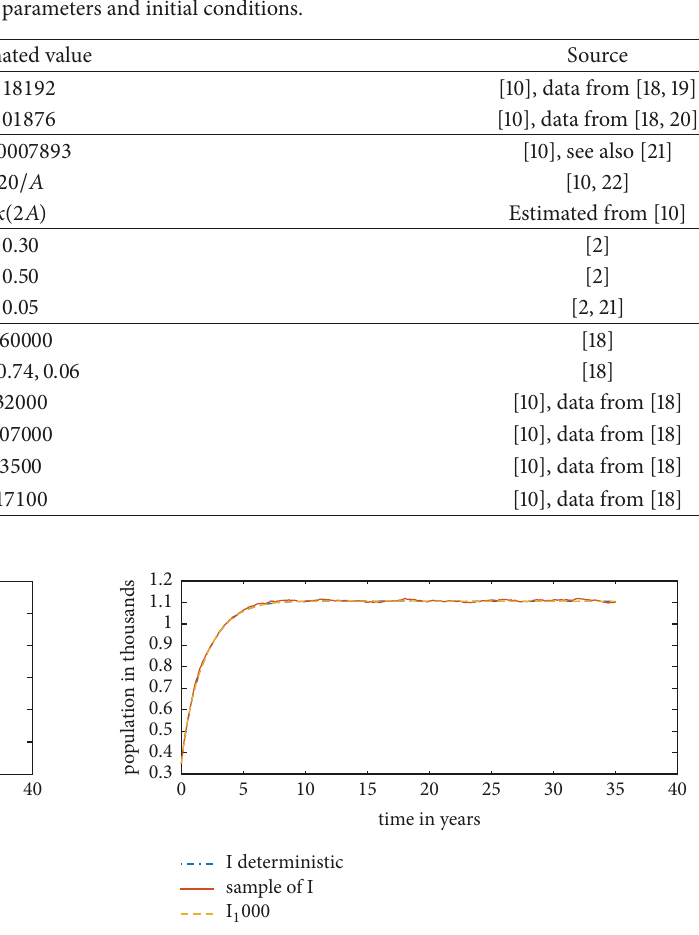
Figure 2: 𝑅 0 = 1.3275 , 𝑅 𝜎 = 0.9737 , and 𝑐 1 = 0.000062 , 𝜎 = 0.05 .